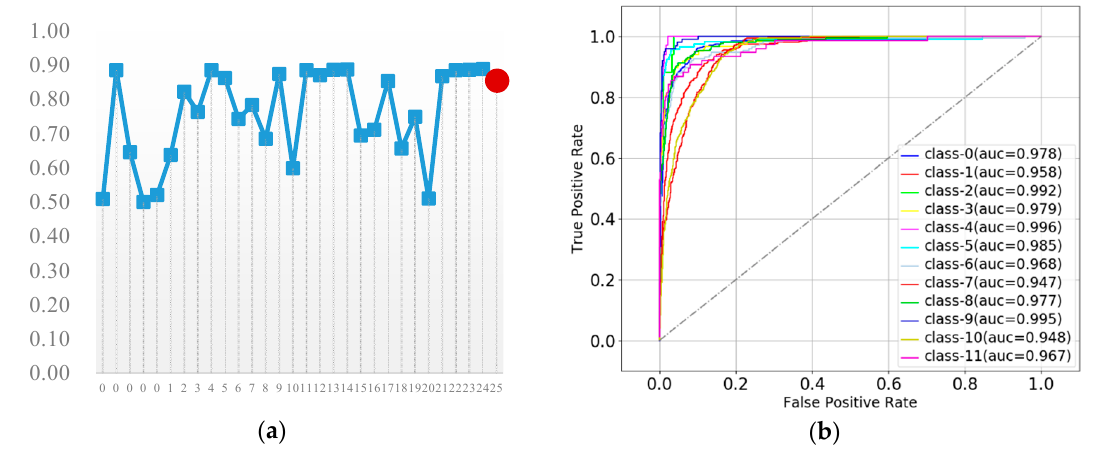
Figure 10. Parameter Tuning Process and ROC of Support Vector Machines (SVM), where ( a ) Description of the parameter tuning process of SVM, where y -axis is ACC and x -axis is iteration; ( b ) ROC of SVM. Table 7. Parameter Tuning Process of SVM Classifier.